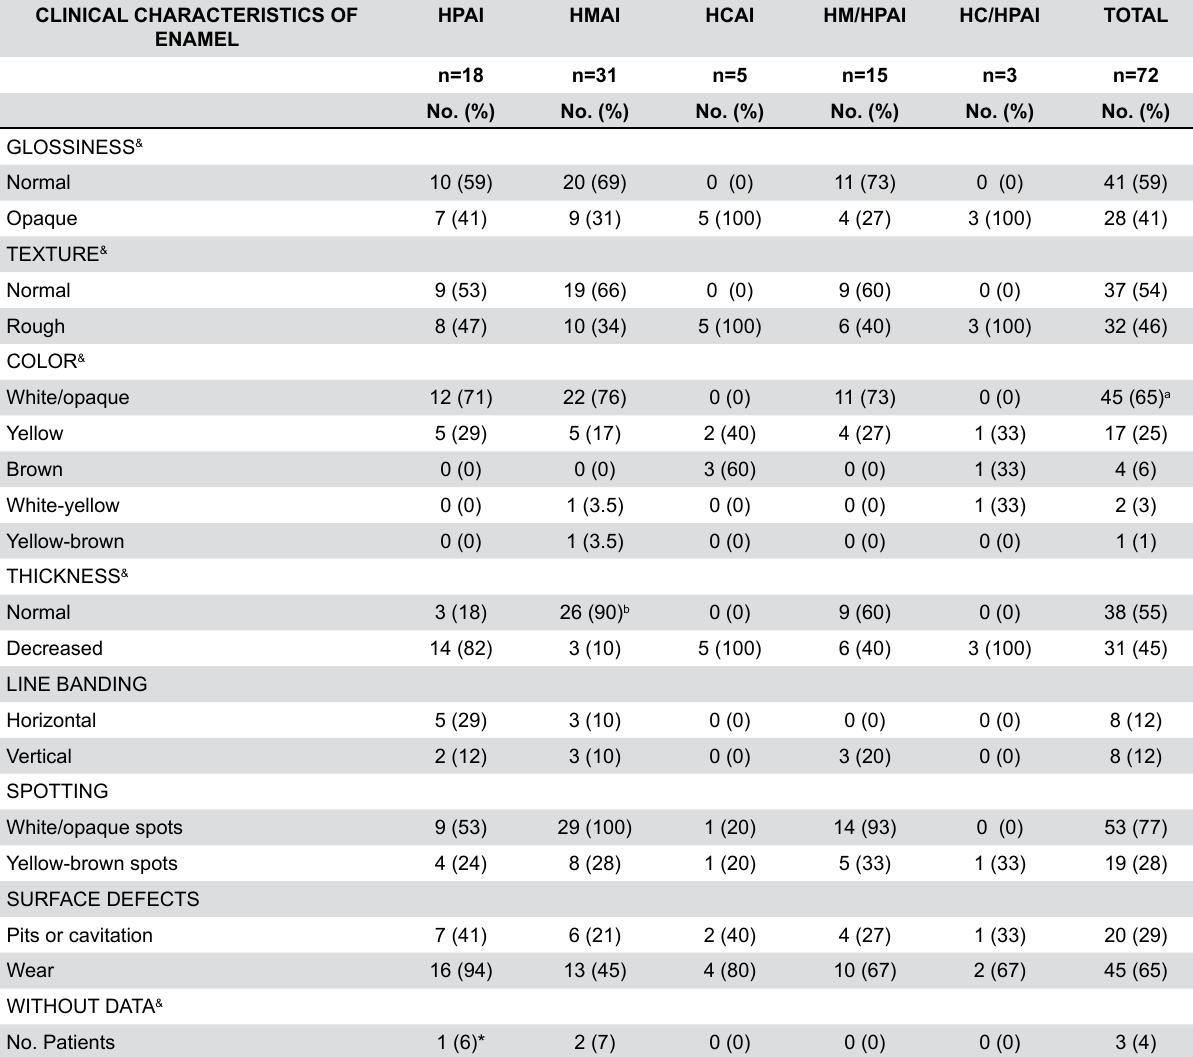
Table 4- Distribution of the general and specific clinical characteristics of the enamel observed in the individuals affected with Amelogenesis Imperfecta (AI) according to clinical